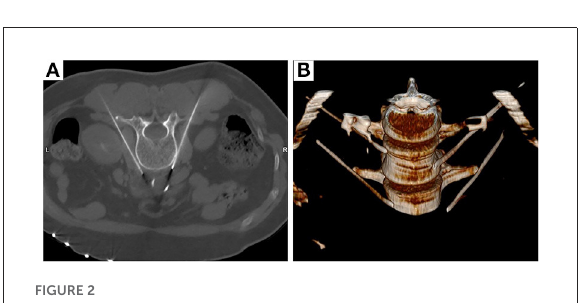
FIGURE2 Radiofrequency targeting points (A) and three-dimensional reconstruction (B) of CT-guided thoracic sympathetic nerve radiofrequency thermocoagulation using the L3 segment as an example.